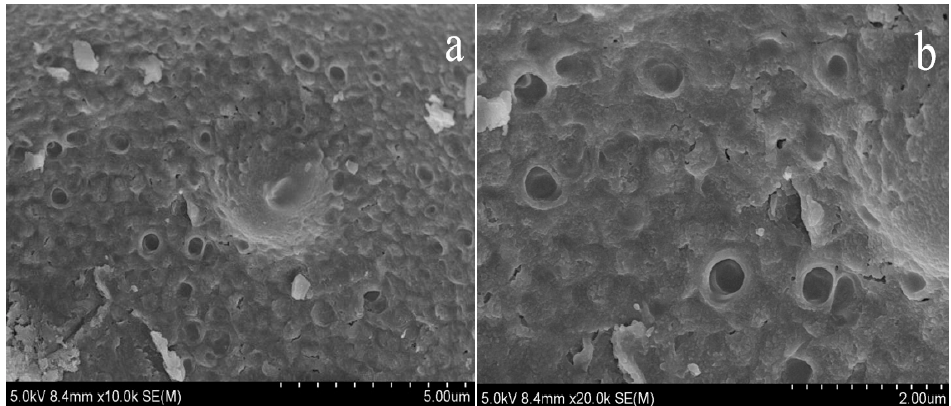
Figure 10. Images of the acid-washed carbonized product of PVC/CuAl-LDH-5%: ( a ) the surface of carbonized product; ( b ) the amplifying surface of carbonized product.